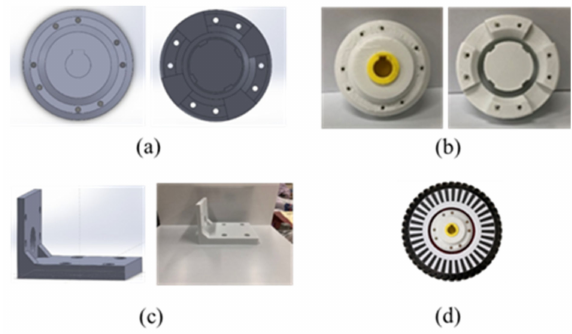
Figure 3. Real design of the proposed smart walker. ( a ) SolidWorks drawn coupling, ( b ) 3D printer made coupling, ( c ) L-shaped bracket with SolidWorks drawing and 3D printing, ( d ) wheel with coupling device and rotary encoder disc.